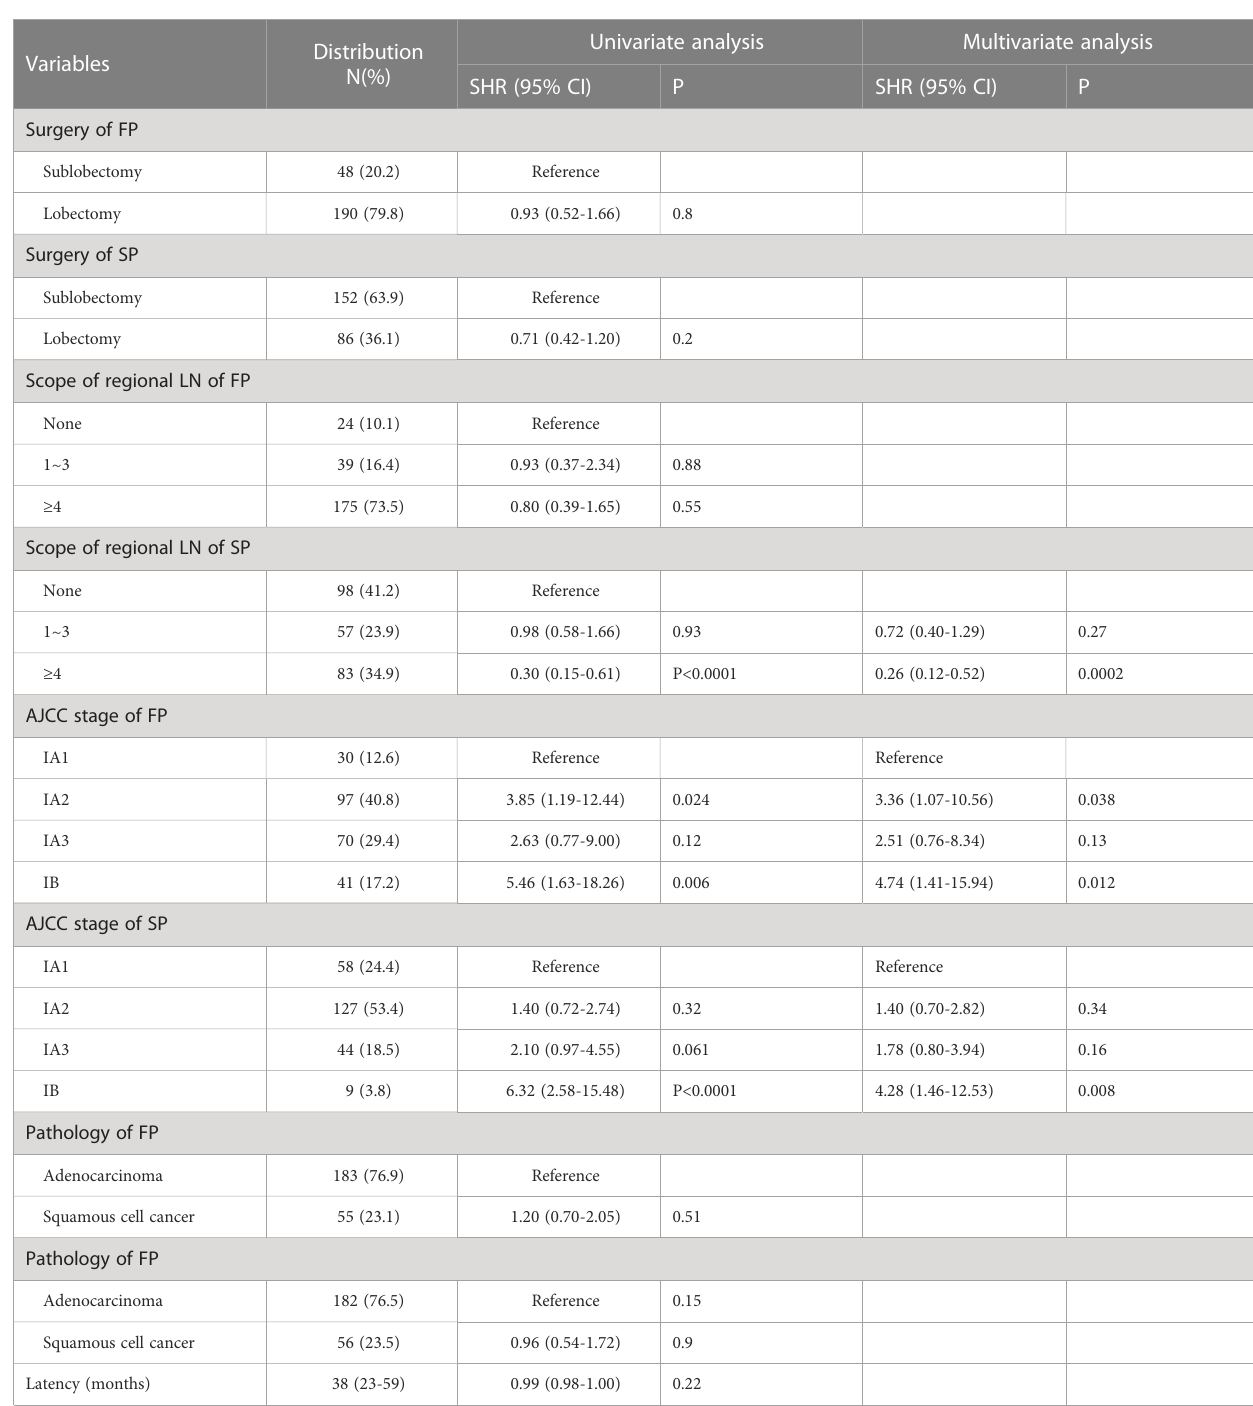
Cumulative incidences of LCSM The CIF curves for estimating the LCSM by different treatment characteristics (surgery and scope of regional LN dissection) of the stage I SP patients are displayed in Figures 3, 4. Overall, the 5-year LCSM rate was 29.8% (CI: 23.1%-36.5%) for the whole cohort. Moreover, the 5-year LCSM rates of the stage I SP patients